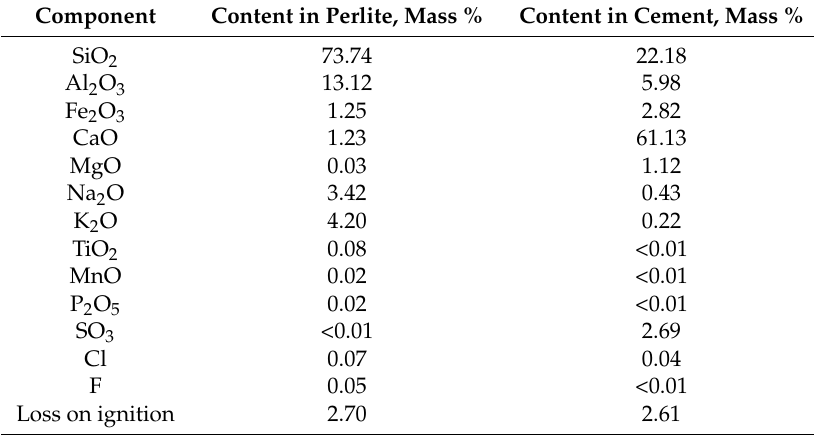
Table 2. Chemical composition of the waste perlite powder and cement CEM I 42.5R used in testing.